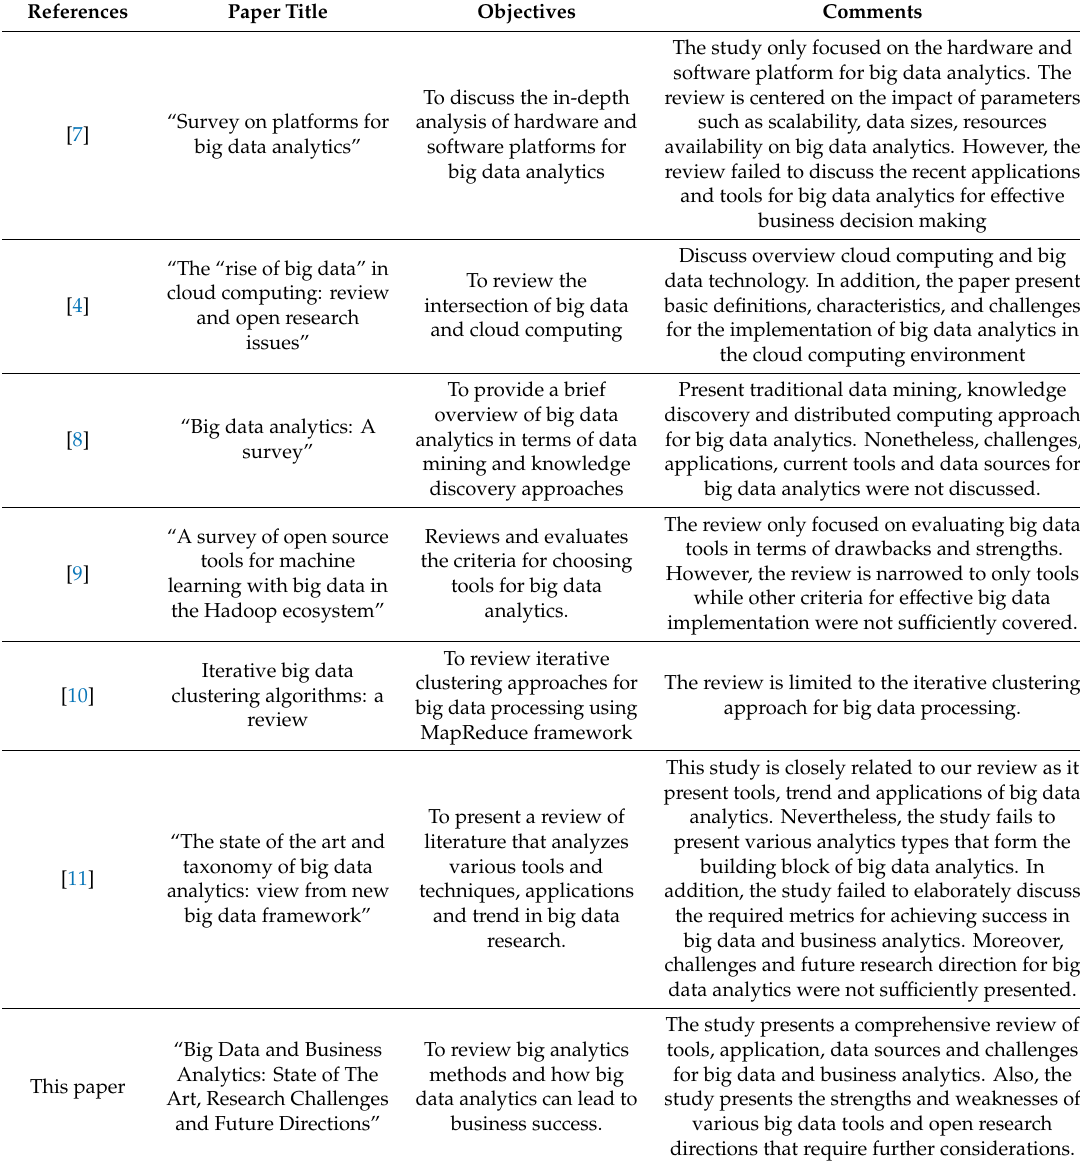
Table 1. Recent review of big data